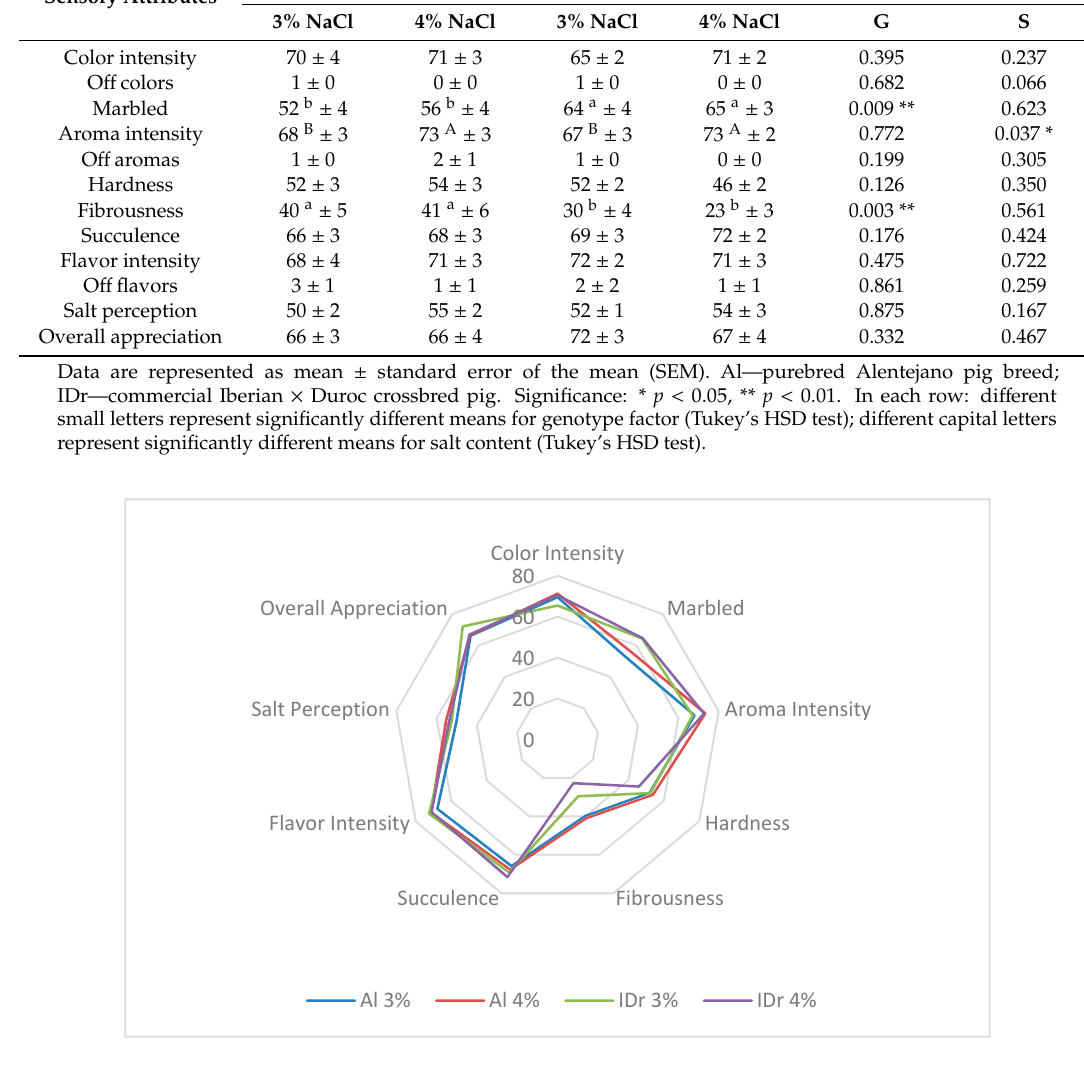
Figure 2. Graphic representation of the Catalão sensory evaluation by quantitative descriptive analysis according to genotype and salt content.